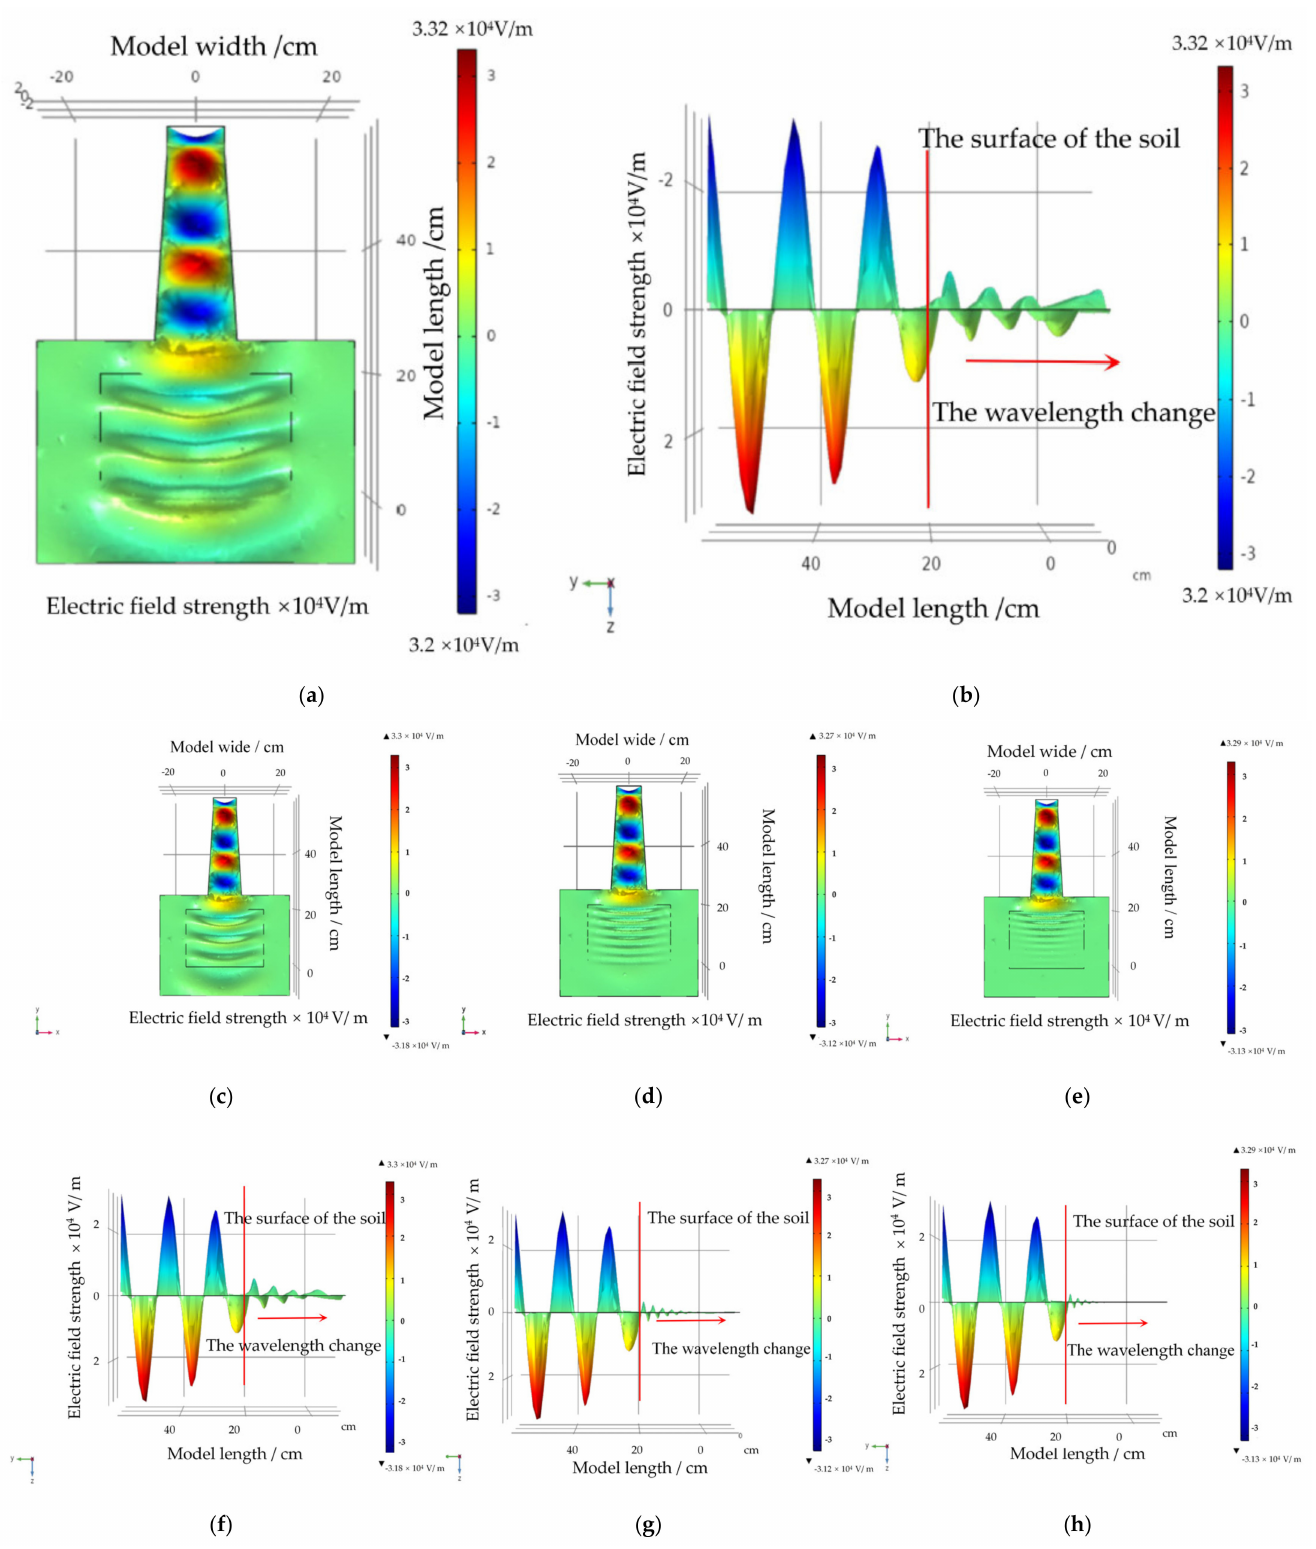
Figure 8. Waveform change after the microwaves enter the soil. ( a ) X-Y view of simulation results of 0% water-containing soil. ( b ) Y-Z view of simulation results of 0% water-containing soil. ( c ) X-Y view of simulation results of 10% water- containing soil. ( d ) X-Y view of simulation results of 20% water-containing soil. ( e ) X-Y view of simulation results of 30% water-containing soil. ( f ) Y-Z view of simulation results of 10% water-containing soil. ( g ) Y-Z view of simulation results of 20% water-containing soil. ( h )Y-Z view of simulation results of 30% water-containing